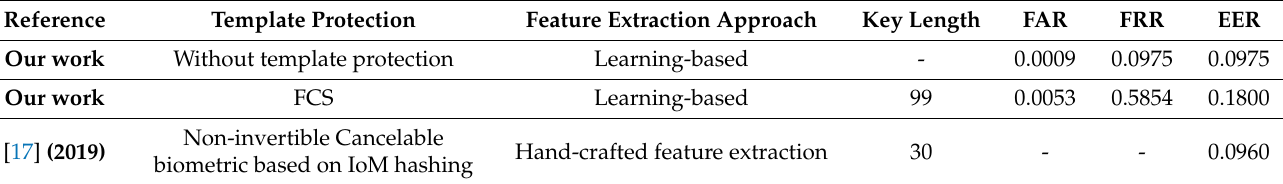
Table 6. Comparison with other works regarding the Touchalytics dataset.